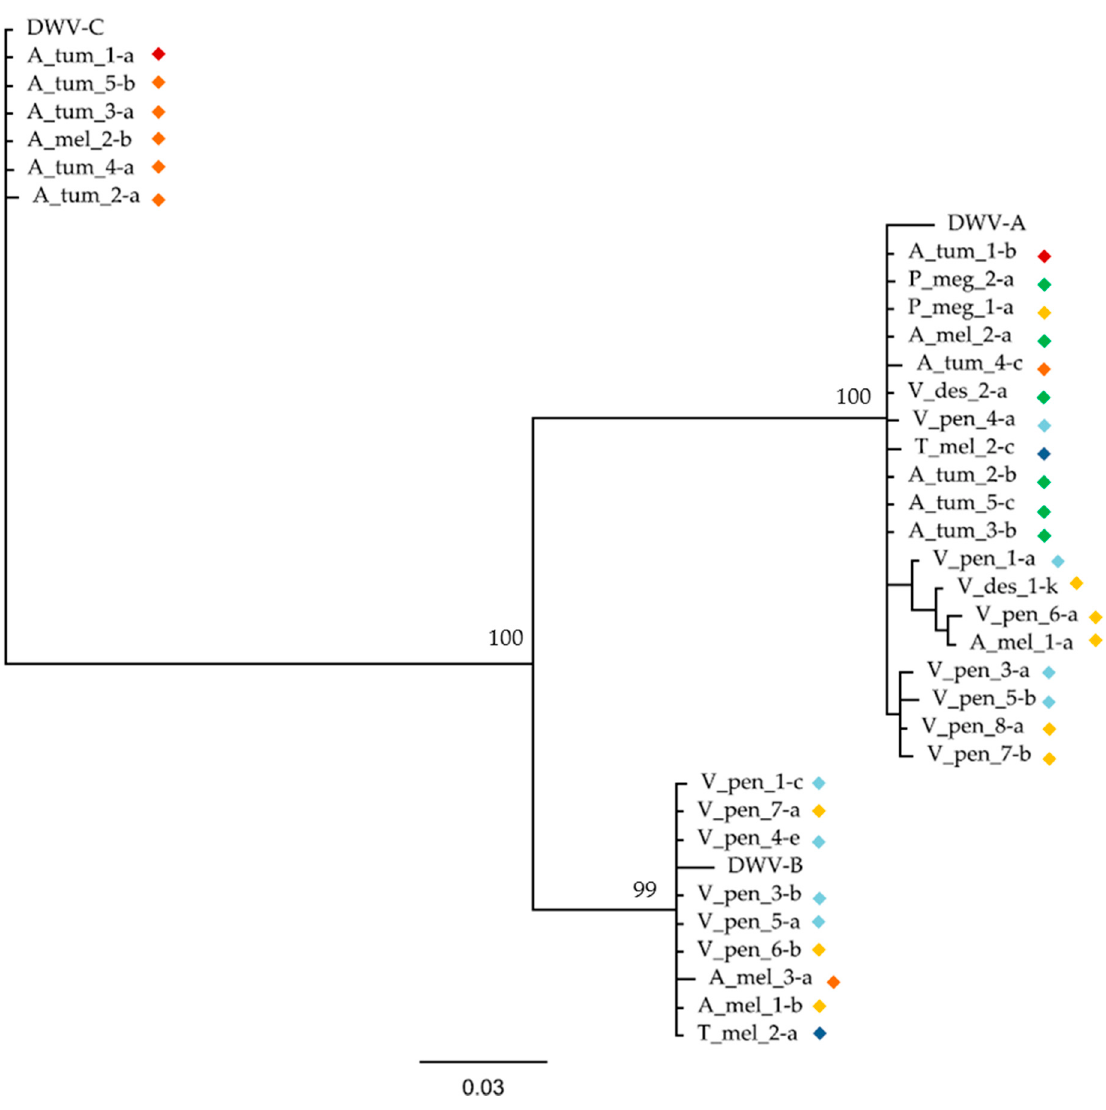
Figure 3. A Bayesian phylogeny of a 507 bp region of the DWV RdRp gene using trimmed contigs assembled for each sample individually using VICUNA, along with the corresponding regions from the DWV-A, B, and C reference genomes (NC_004830.2, AY251269.2, and CEND01000001.1). Colored diamonds represent the sample collection location: O1 = green, O2 = red, B1 = orange, B2 = dark blue, B3 = yellow, and B4 = light blue. Sample name suffixes represent the contig name. The bar represents the number of nucleotide substitutions per site, and the consensus support (%) is shown for selected branches.